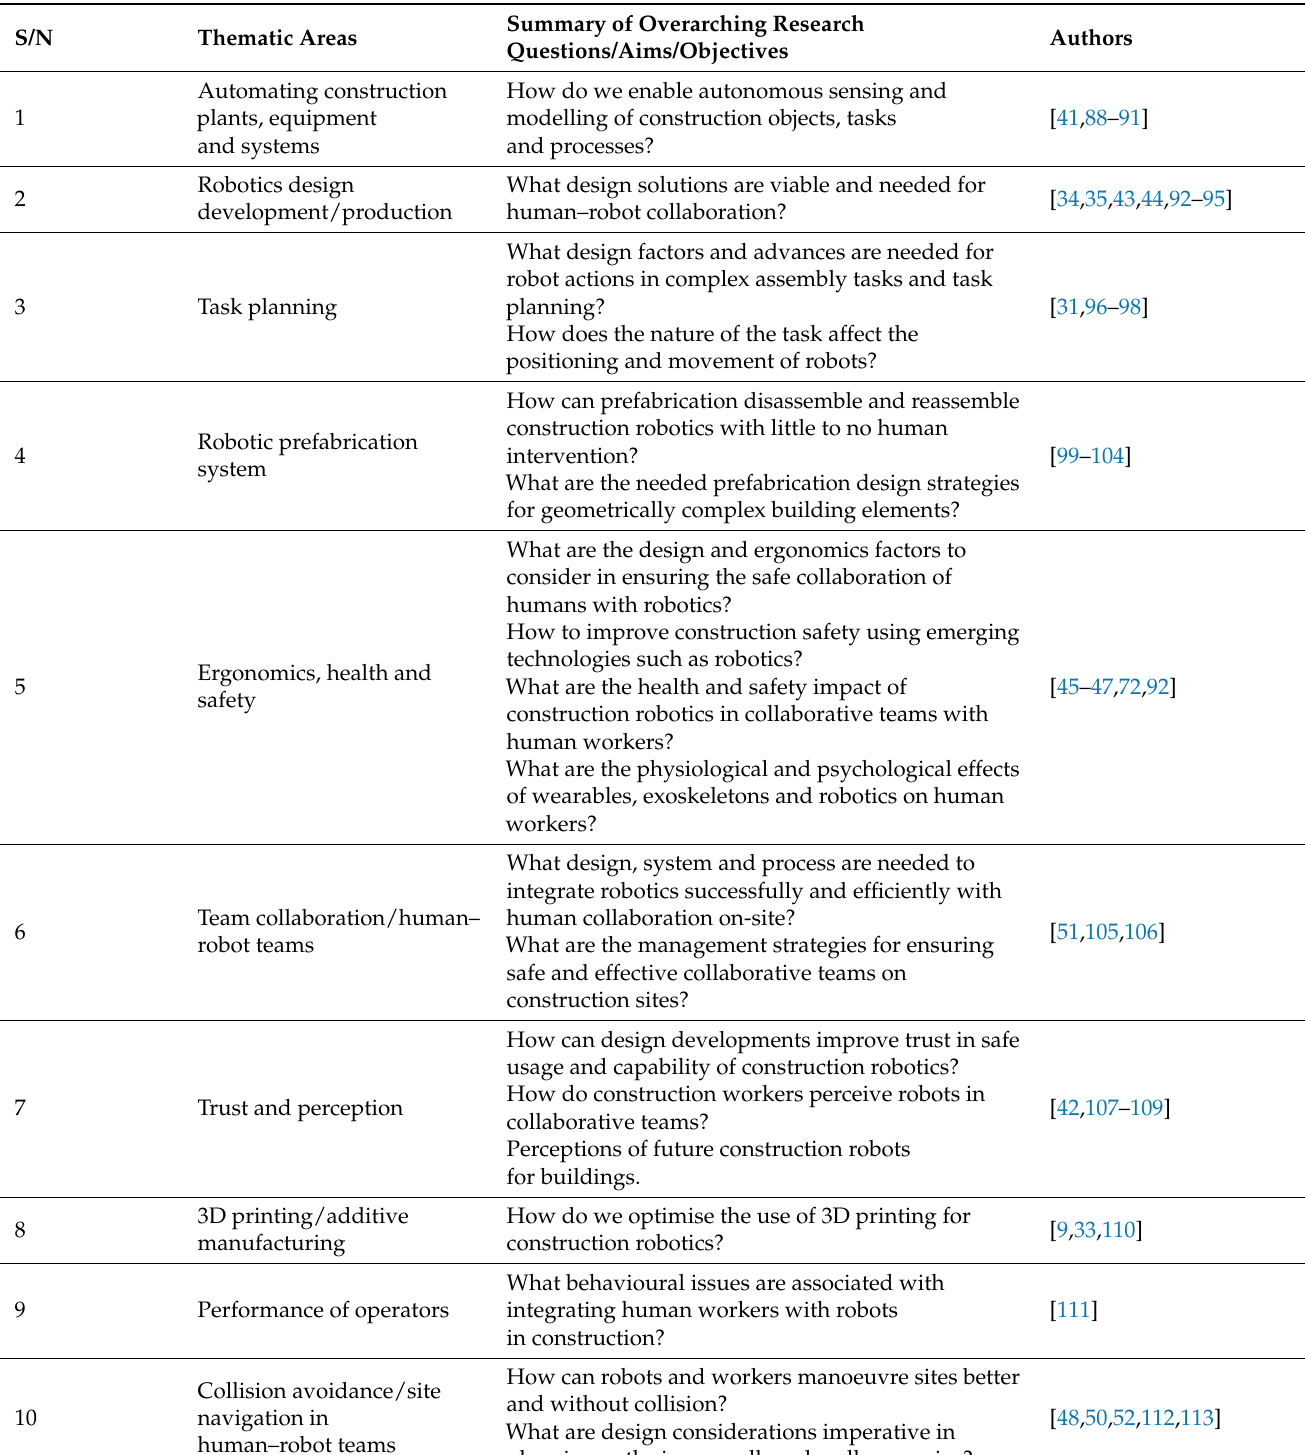
Table A1. Summary of Overarching Research Questions/Aims/Objectives and thematic